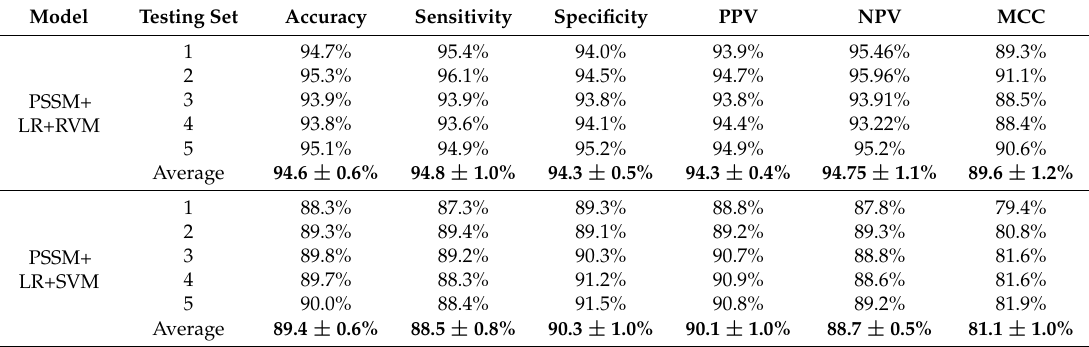
Table 1. Five-fold cross-validation results shown using our proposed method on the Yeast dataset. Model Testing